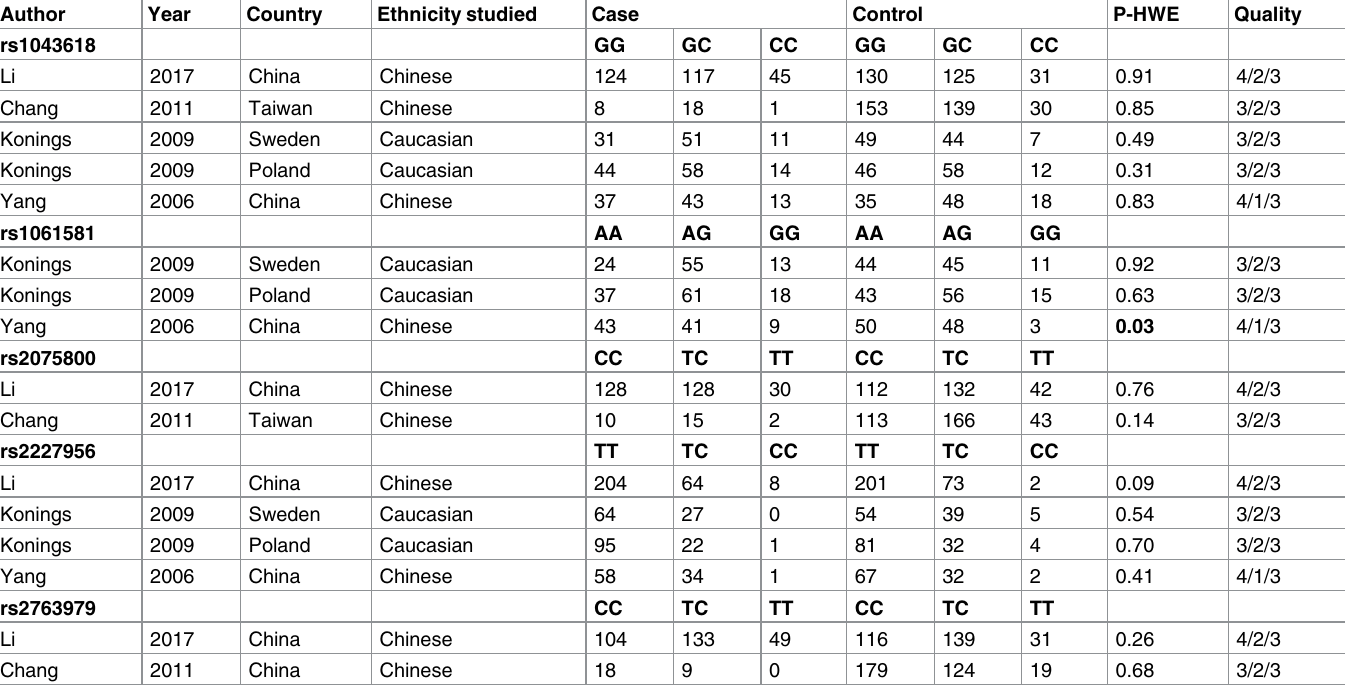
Table 1. Characteristics of studies included in the meta-analysis.